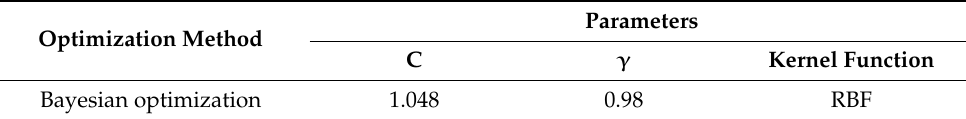
Table 4. SVM hyperparameters.